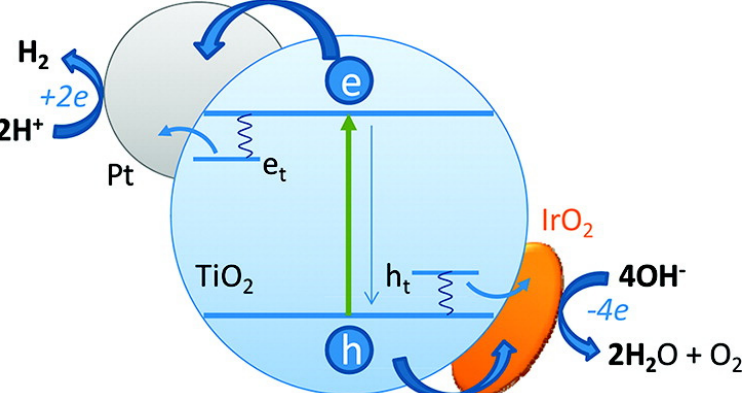
Figure 3. Schematic of the charge transfer across semicopnductor interface. Note: This figure is reproduced with permission from [12], Copyright © 2012